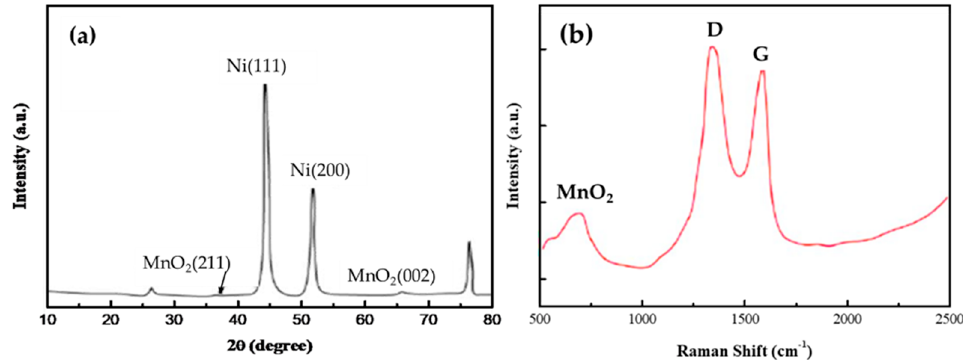
Figure 2. The XRD patterns of the MnO 2 /graphene/Ni electrode ( a ) and Raman spectra of the MnO 2 /graphene/Ni electrode ( b ) The D band is a common feature for sp3 defects or disorder in carbon, and the G band provides useful information on in-plane vibration of sp2-bonded carbon atoms in a 2-D hexagonal lattice [26].(2) HOW IS D & G IN THE CASE (LAST APPROVED) The relative intensity ratio of the D-band to G-band, defined as R = ID/IG, represents the structural regularity of graphene. The R-value was proposed to be an indication of disorder in graphene. The smaller the R value, the greater the regularity is. As seen from Figure 2b, the R-value is approximately 1.15, demonstrating an irregular structure in gra- phene compare with our previous study [27].